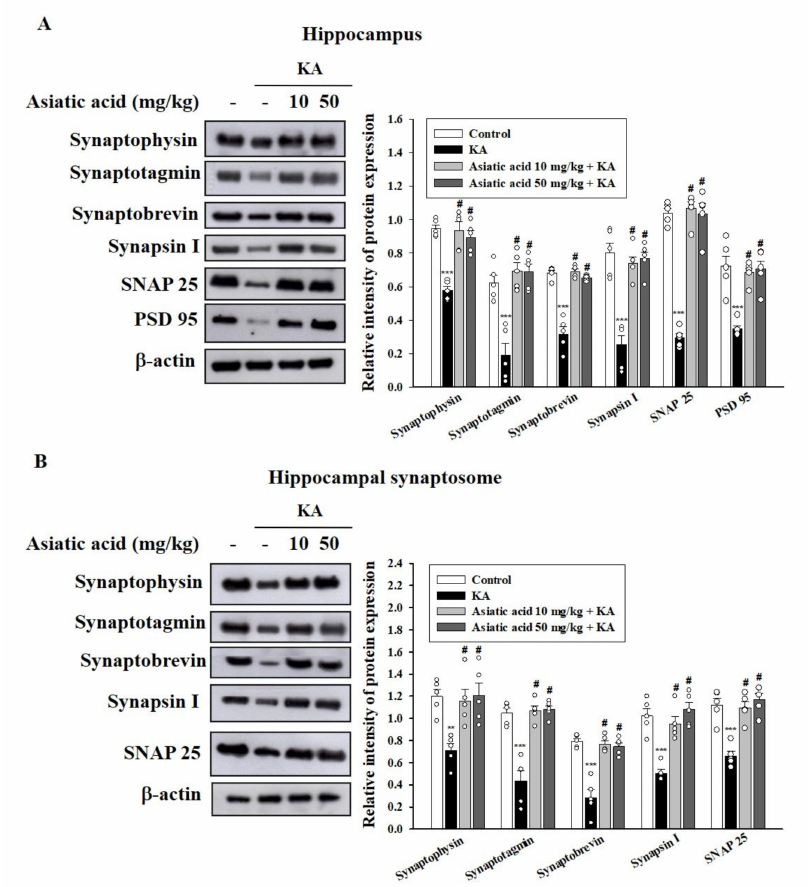
Figure 5. Effects of asiatic acid pretreatment on the levels of synaptic proteins in the hippocampus of rats with KA-induced seizures. Western blot showing the expression levels of synaptophysin, synaptobrevin, synaptotagmin, synapsin-1, and SNAP-25 (synaptosomal-associated protein 25 kDa) in the hippocampal tissues ( A ) and hippocampal synaptosomes ( B ) for each group. The relative protein levels were quantified. ** p < 0.01, *** p < 0.001 (vs. control); # p < 0.001 (asiatic acid + KA vs. KA); n = 5 rats per